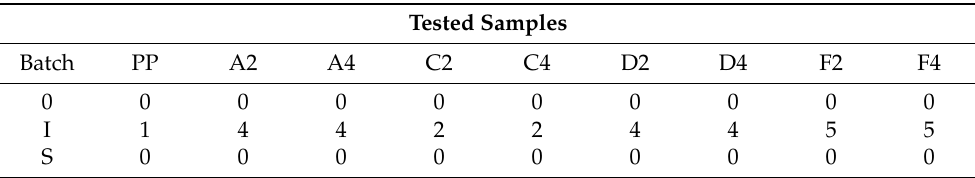
Table 4. Fungal growth on test samples (Method B)—result of visual assessment of samples based on Table 2.